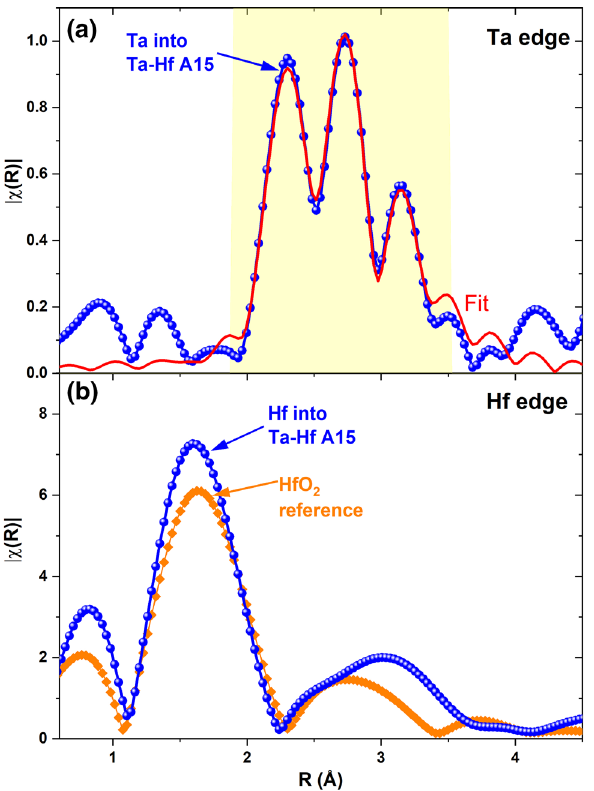
Figure 4. EXAFS characterization of Ta-Hf-doped sample. Fourier transforms of the k 2 weighted χ ( k ) data for the ( a ) Ta L 3 and ( b ) Hf L 3 edges of the EXAFS characterizations of the Ta-Hf-doped Nb 3 Sn sample heat treated at 670 °C (blue dots) and of the reference HfO 2 sample (orange diamond). In ( a ) the red line is the two-site fit for the Nb 3 Sn structure (fitting window of interest for Nb 3 Sn from 1.9 to 3.5